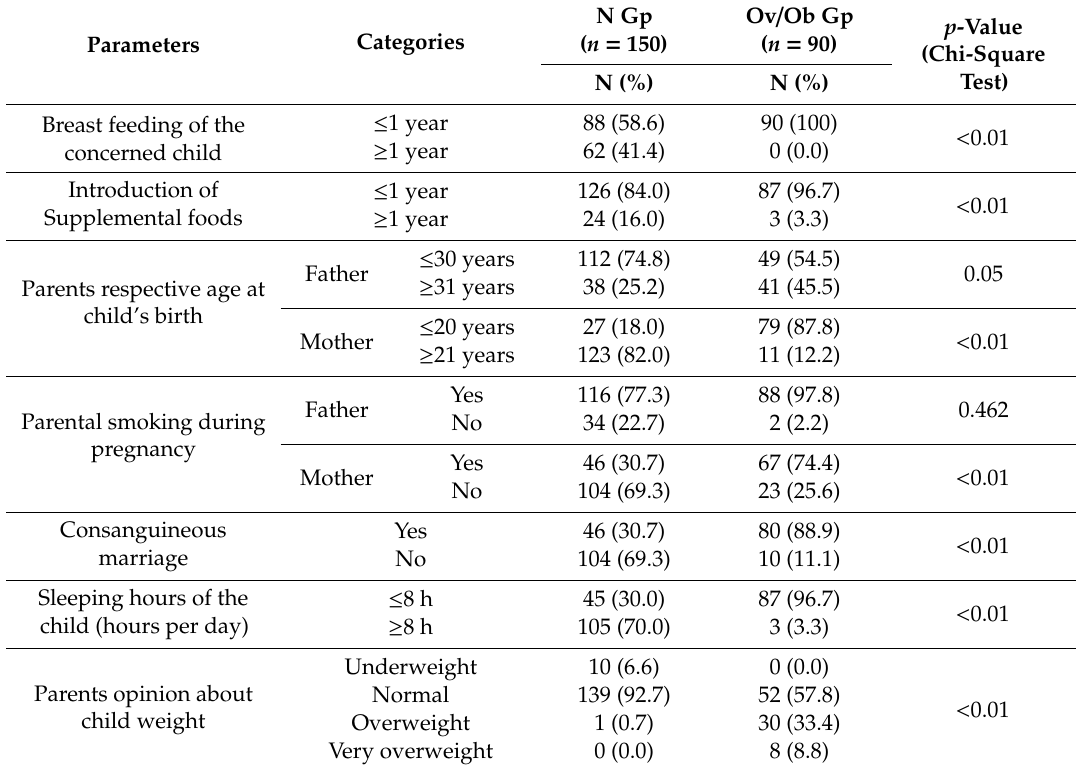
Table 2. Comparative di ff erences of environmentally modulated parental variables between study